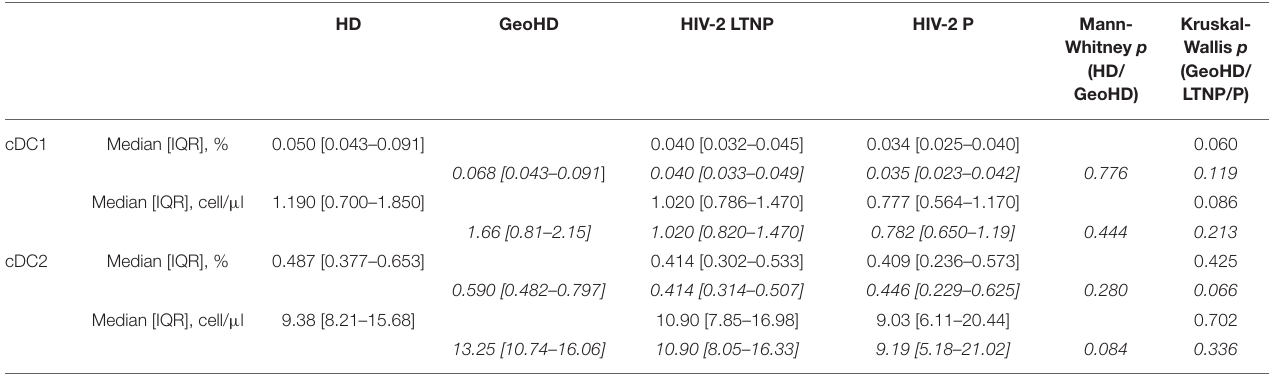
TABLE 3 | Conventional cDC1 and cDC2 percentages among CD45 + PBMC and absolute counts in HIV-2-infected and uninfected donors.